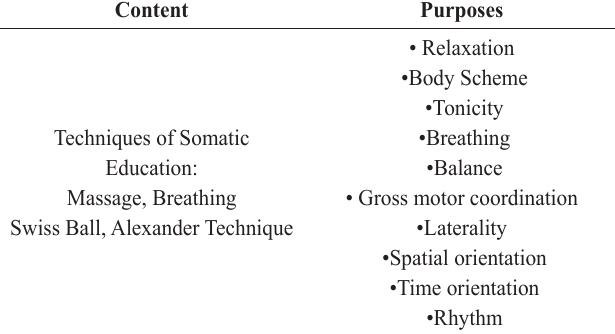
Table 1. Data relating to the contents worked during the dance program with their